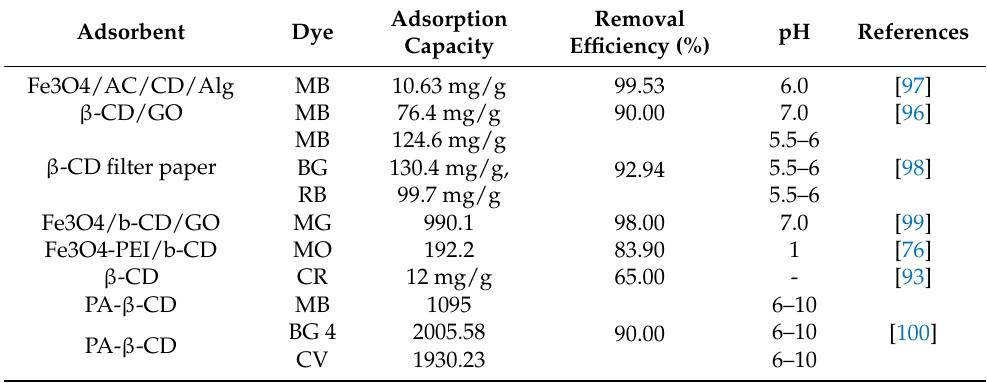
Table 1. Adsorption capacities of various CD-based adsorbents for